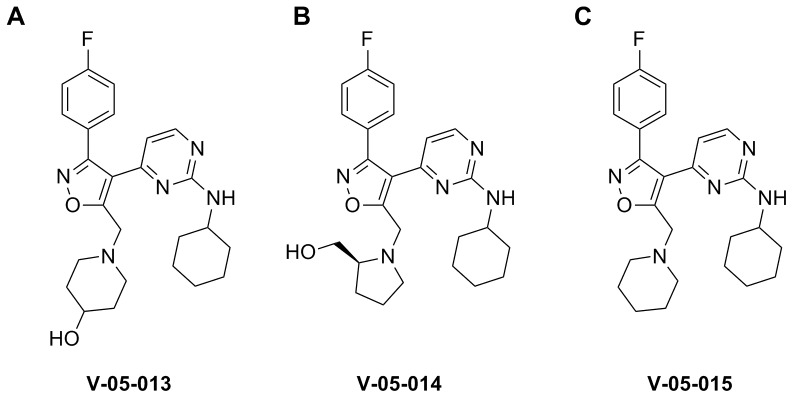
Chemical structures of dual p38 and JNK MAPK inhibitors.